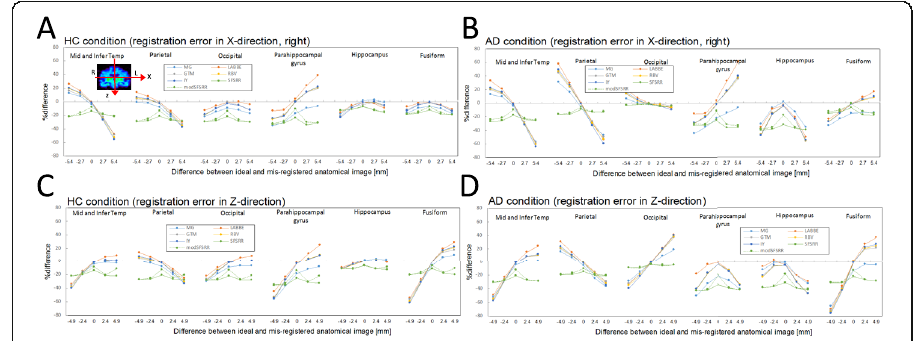
Fig. 5 %difference of PVC-SUVRs with registration error ( X ) against true SUVRs. a HC condition and b AD condition and PVC-SUVRs with registration error ( Z ) against true SUVRs: c HC condition and d AD condition. ROI templates were from accurately registered anatomical images